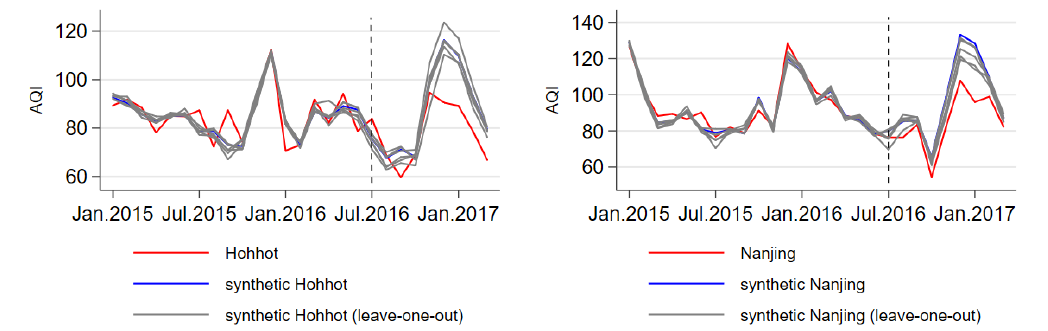
Figure 5. Leave-One-Out Distribution of the Synthetic Control for treatment